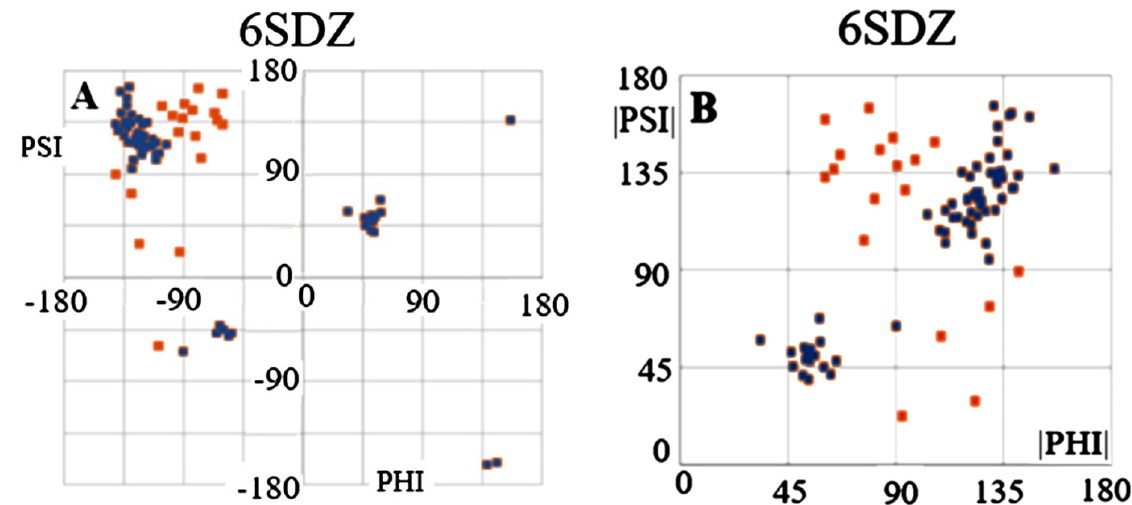
Figure 2. Ramachandran map: ( A )—a comparison of the Phi and Psi angles for the complete chain of the amyloid form transthyretin (6SDZ), navy blue—points treated as outstanding; ( B )—processed Phi and Psi angles—absolute values of angles highlighted as navy blue points—set after eliminating outstanding positions.